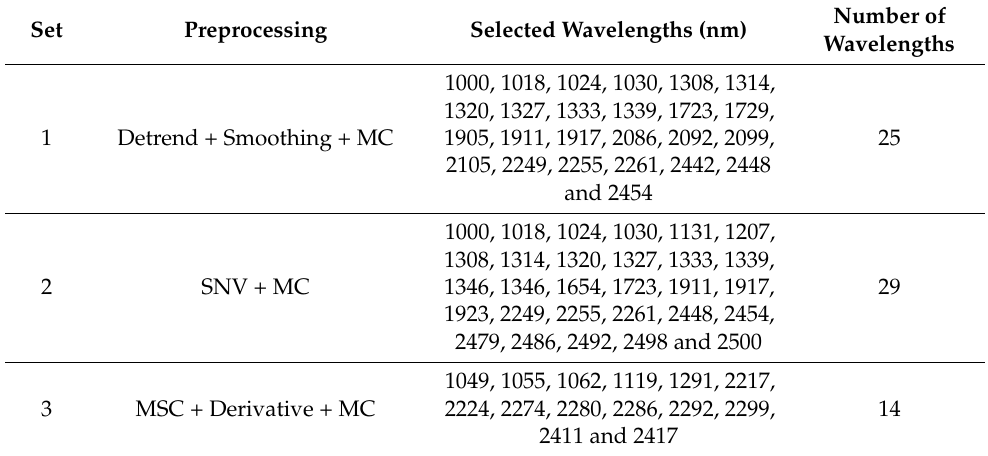
Table 2. Different preprocessing sets and corresponding selected wavelengths, using CARS method.